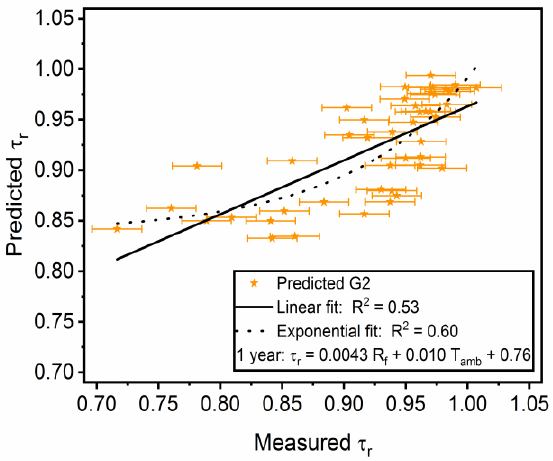
Figure 13. Regression plot of predicted transmittance and measured transmittance of weekly cleaned glass (G2) using the MLR model for a year. The uncertainty associated with the average relative direct transmittance of the weekly cleaned glass coupon is ±0.02. The solid line represents the linear fit and the dashed line represents an exponential fit with an offset to guide the eye. For the values of parameters of the linear and exponential fits refer to Tables S8 and S9.